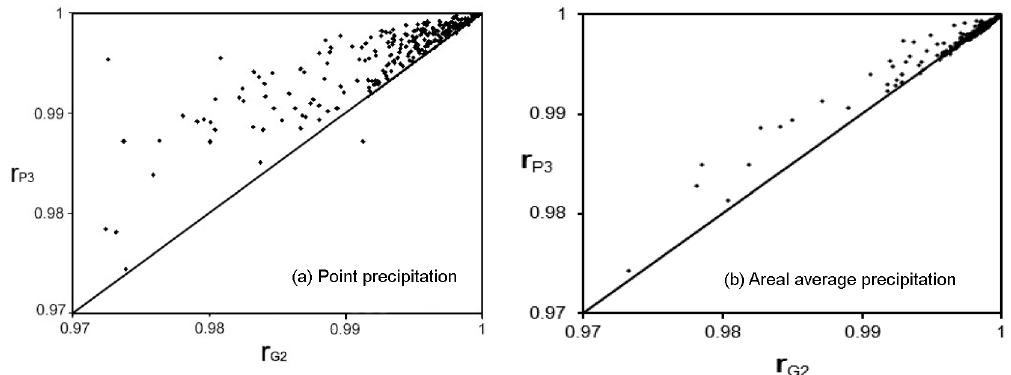
Figure 7. Comparison of PPCC ( r ) values for the P3 (vertical axis) and G2 (horizontal axis) distributions for the (a) point, and (b) areal average precipitation depths series. Points lying above the line represent stations with a higher r for the P3 distribution than G2 distribution.